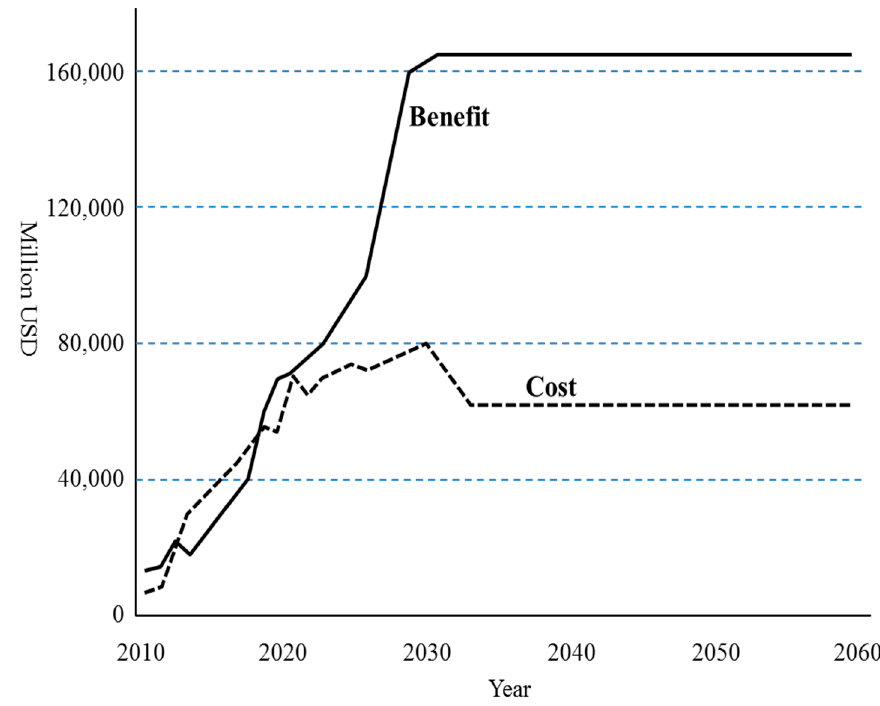
Figure 4. Long-term comparison of benefits and costs of the groundwater monitoring networks.